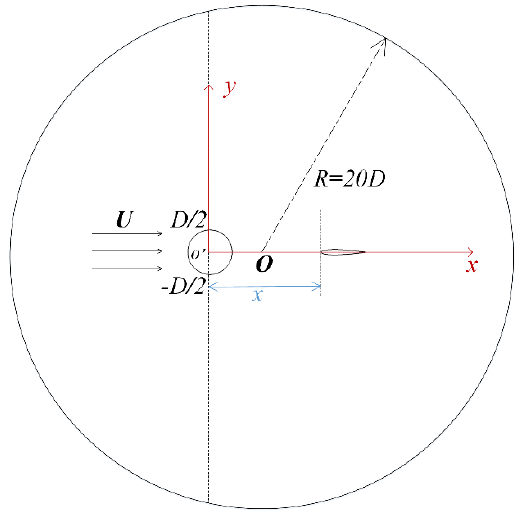
Figure 2. Schematic of the computational domain. Table 1. Computational parameters.